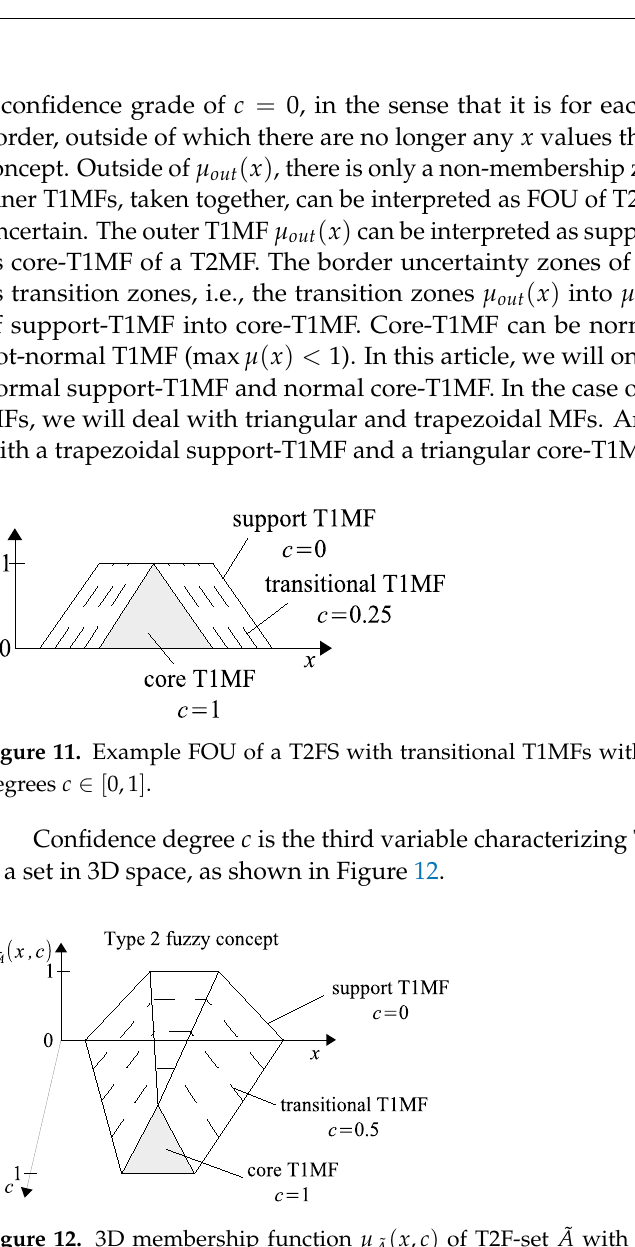
Figure 12. 3D membership function µ ˜ confidence c